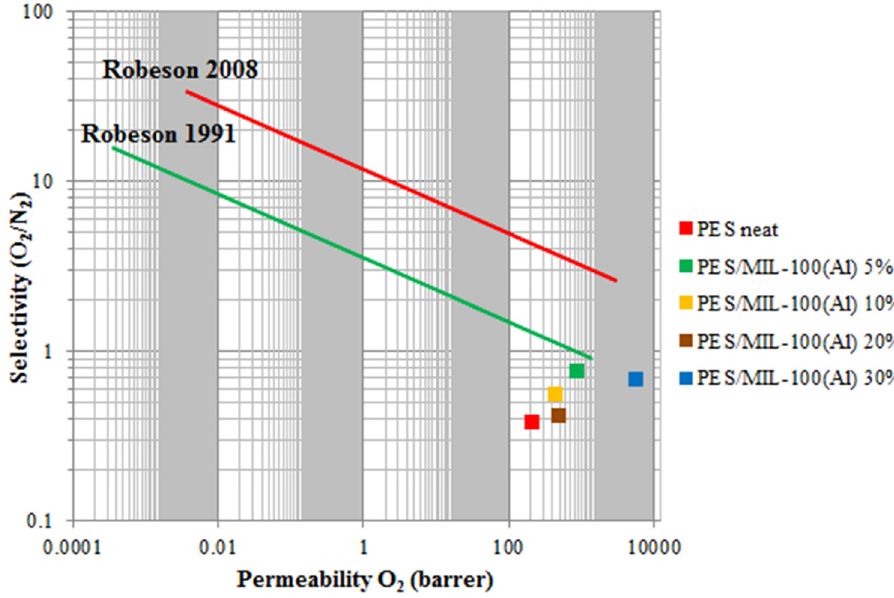
Figure 15: Comparison of the O 2 /N 2 gas separation performance as compared with the literature [ 48,49 ] .